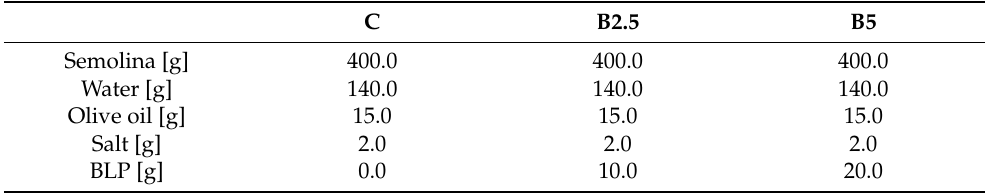
Table 1. Formulations of control and fortified pasta. C (control pasta); B2.5 pasta fortified